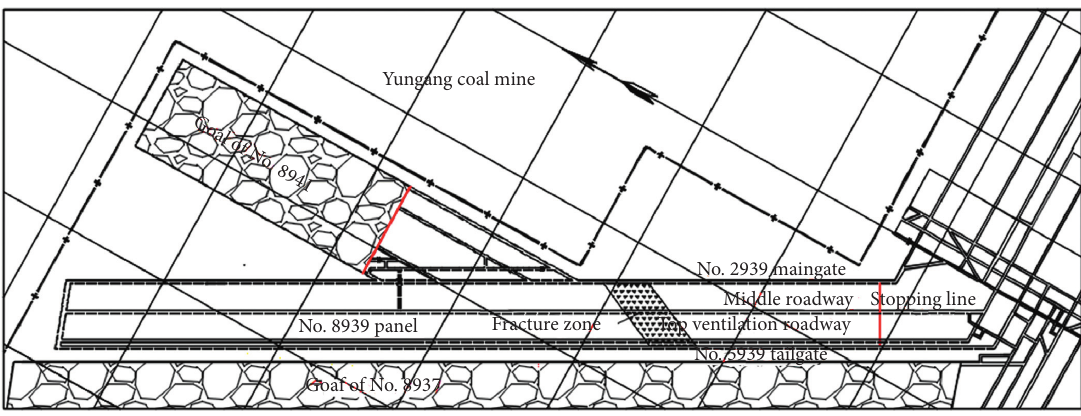
Figure 4: Plan view of no. 8939 longwall panel.